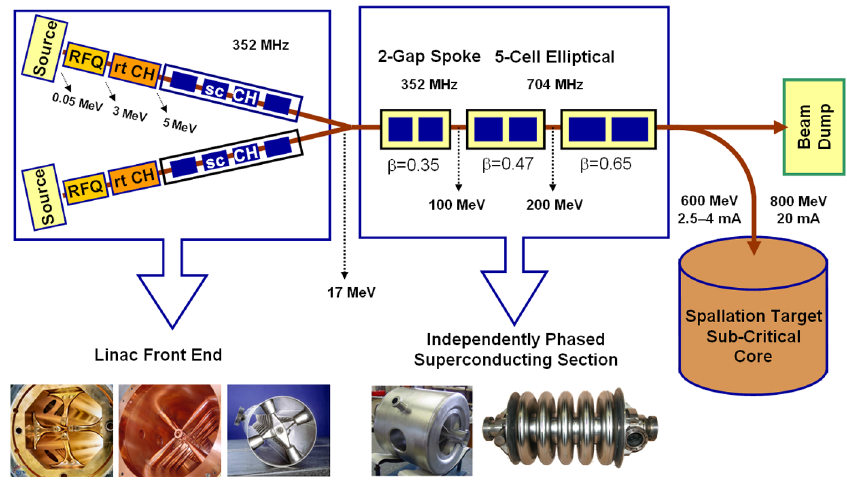
FIG. 2. (Color) The reference layout of the planned EUROTRANS facility